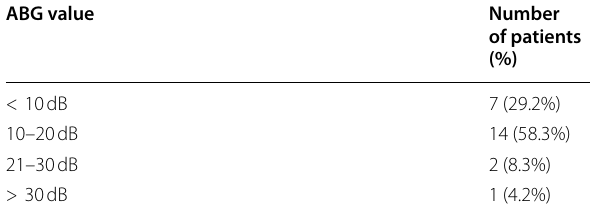
Table 1 Post-operative air-bone gap at the end of 1st month